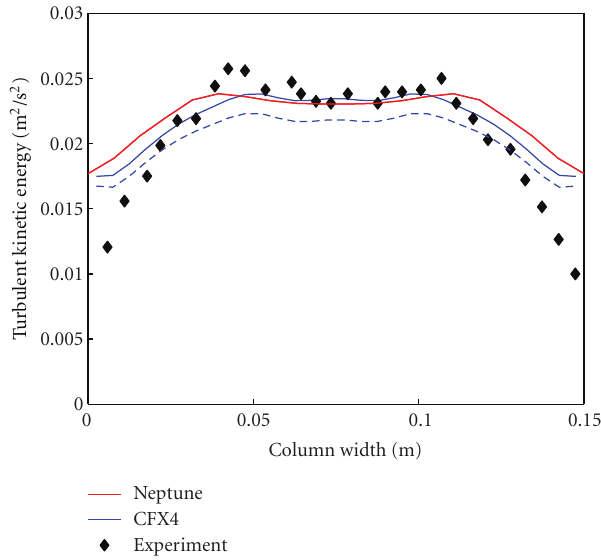
Figure 9: Comparison of liquid turbulent kinetic energy obtained with CFX-4 using one-equation model and Neptune CFD with Smagorinsky model and experimental data. The blue dashed line is the resolved, the blue continuous line is the total (resolved plus SGS) kinetic energy (from Niceno et al.